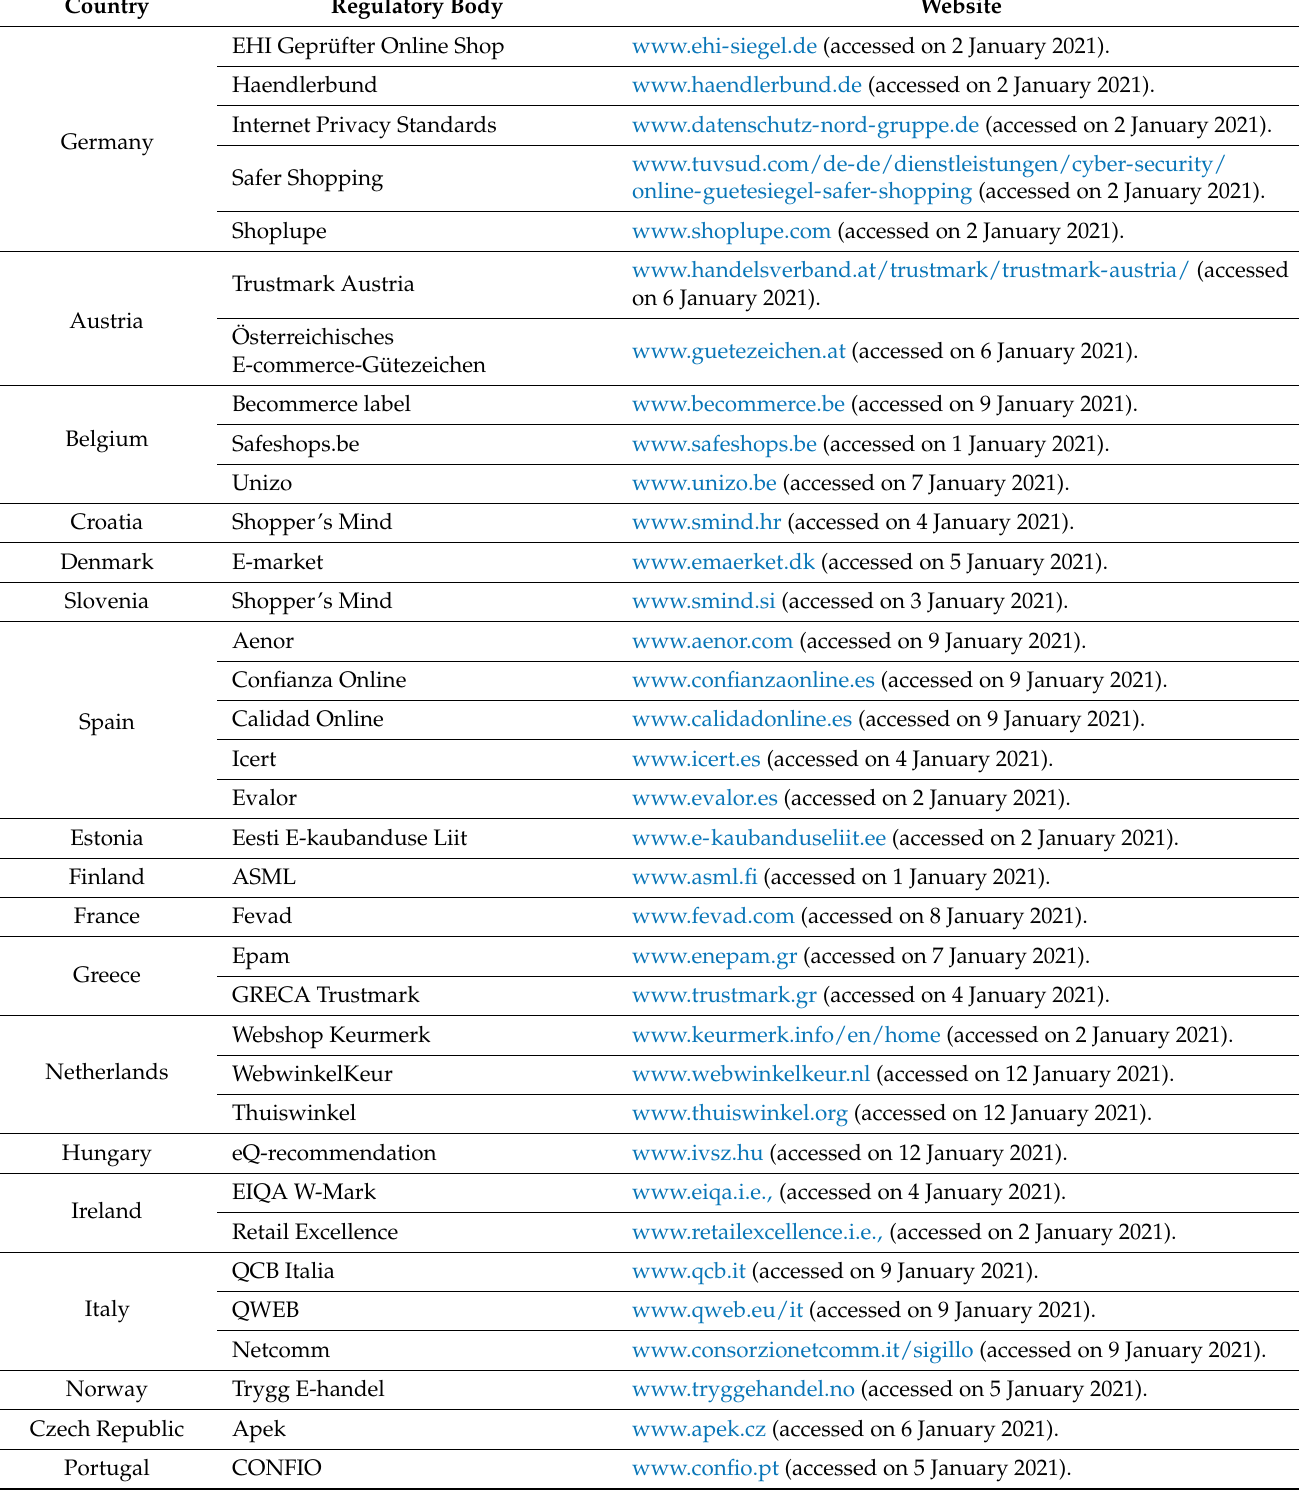
Table 2. List of Trust Seals in Europe and Latin